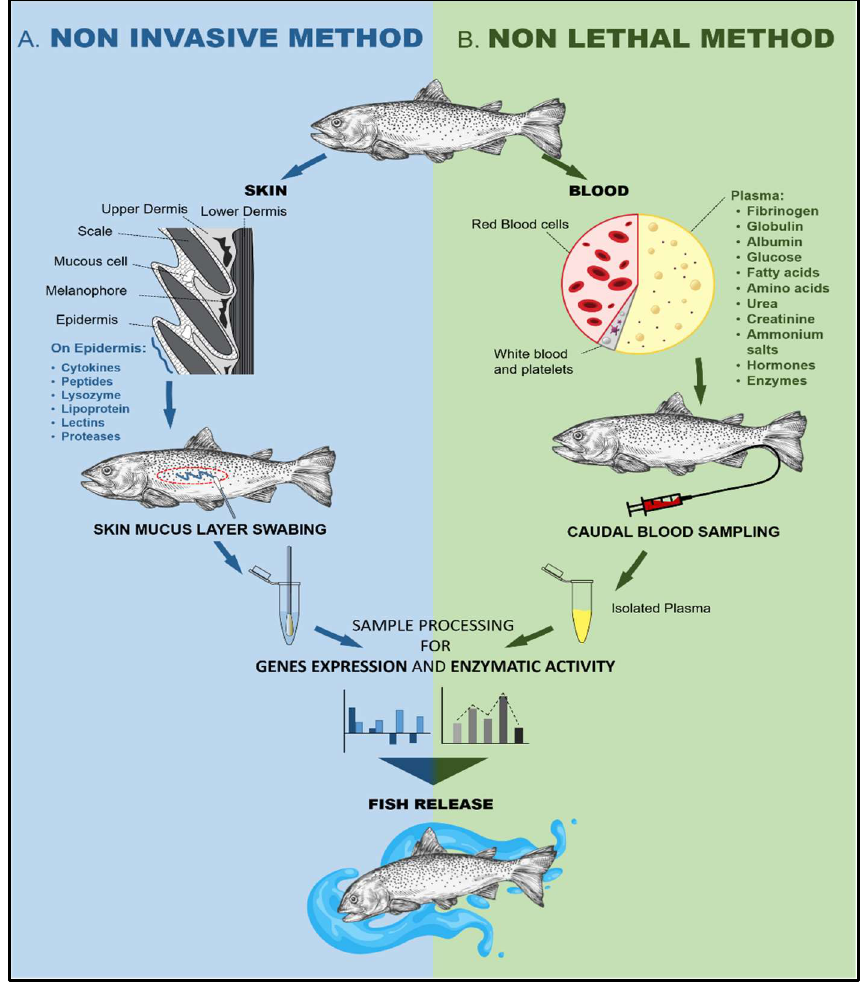
Figure 3. Non-invasive and non-lethal methods used to detect antioxidative biomarkers. ( A ) Non-invasive method concerning fish skin epidermis, which consists in gently scraping the body surface with a sterile spatula followed by sample processing for gene expression and enzymatic activity. ( B ) Non-lethal method concerning blood plasma obtained by heparinized needle syringe into the ventral surface midline of the caudal peduncle posterior to the anal fin, followed by sample processing for gene expression and enzymatic activity.